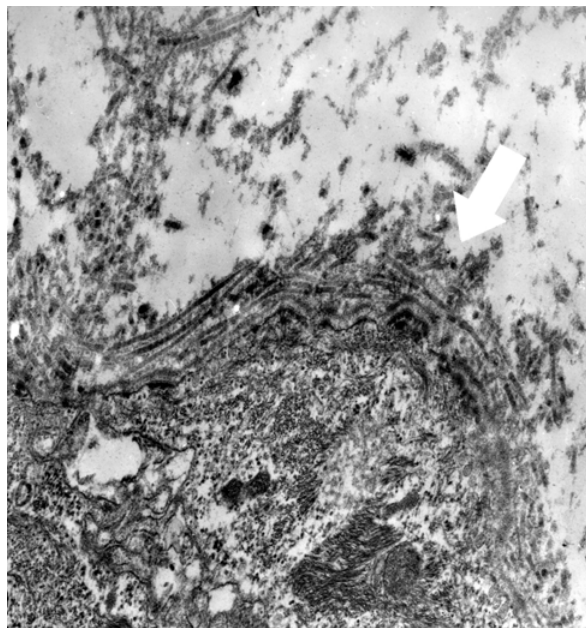
FIGURE 9- TEM micrograph showing collagen fibers organized parallel bundles under the basement membrane